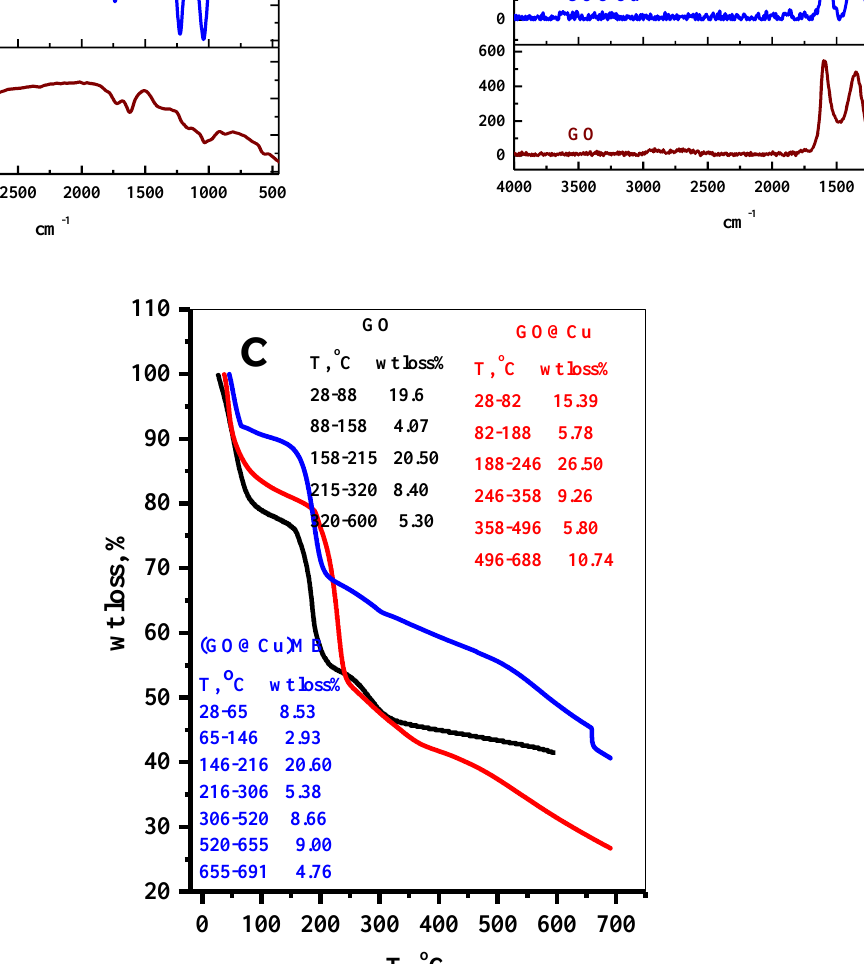
Figure 3. ( a ) FT-IR spectrum, ( b ) Raman spectrum for GO, GO @ -M composite and (GO @ M)-MB complex (M = Cu 2+ or Fe 3+ ). For GO, GO @ M composite and (GO @ M)-MB, (M = Cu 2+ or Fe 3+ ), and ( c ) TGA plot for GO, GO @ Cu, and (GO @ Cu)-MB.